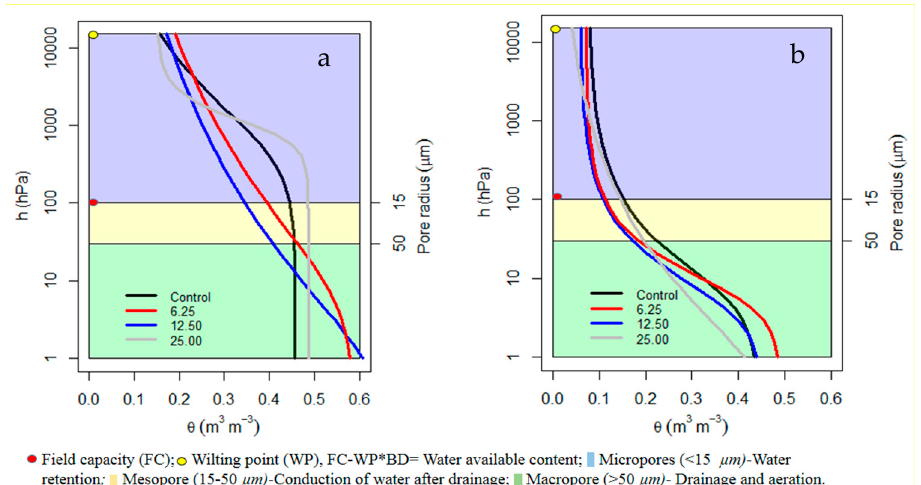
Figure 4. Effect of biochar amount on soil water retention in clay loam and sandy soil. ( a ) Clay loam soil; ( b ) Sandy soil